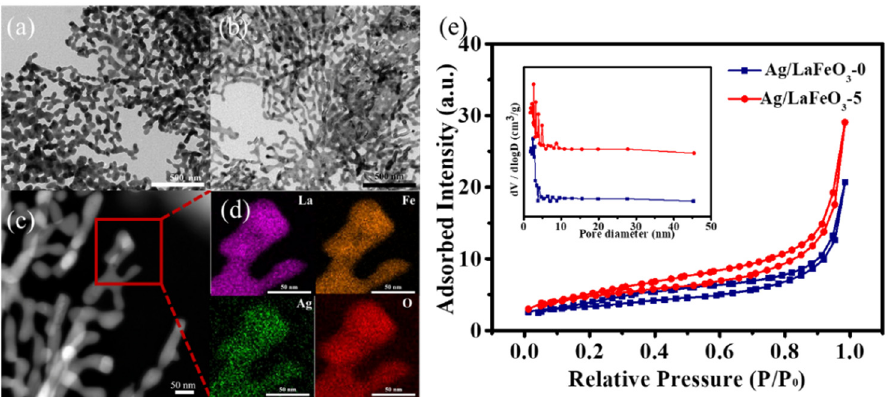
Figure 3. TEM of ( a ) Ag/LaFeO 3 − 0; and ( b ) Ag/LaFeO 3 − 5; ( c , d ) the STEM-EDS elemental mapping images of Ag/LaFeO 3 − 5; ( e ) BET characterization of Ag/LaFeO 3 − 0 and Ag/LaFeO 3 − 5, and the inset shows the pore size distribution of the corresponding composites.